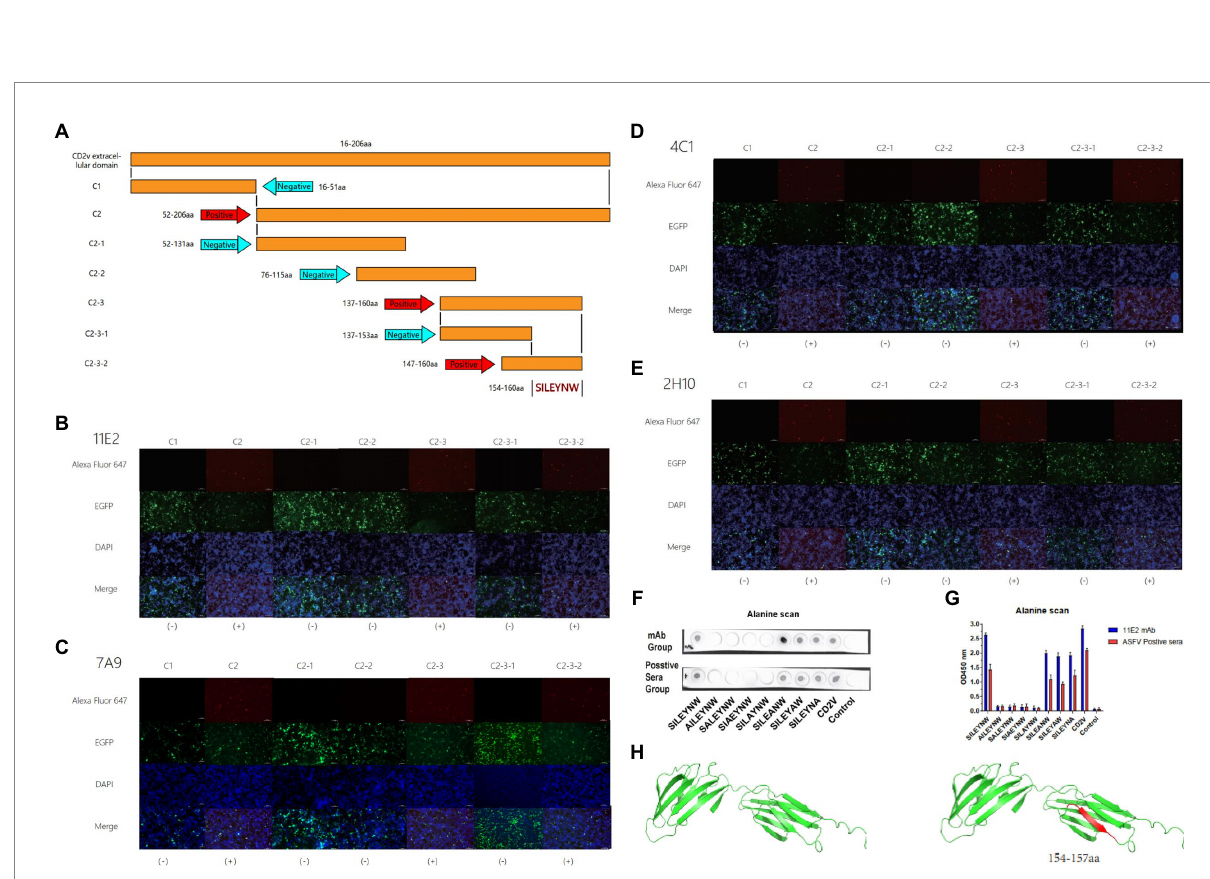
FIGURE 2 Mapping of critical binding epitope by mAbs and simulation of CD2v protein. (A) Design and presentation of amino acid sequences. (B–E) The binding of epitopes to mAbs was identified by IFA. (B–E) of 11E2, 7A9, 4C1 and 2H10 reacted with truncated sequences for epitope identification. (+) is a positive reaction. ( − ) indicates a negative reaction. (F) Dot-blot (G) Peptide-based ELISA. Identification of core residues. (H) Simulation of the epitope position in the CD2v protein. Epitope was marked by